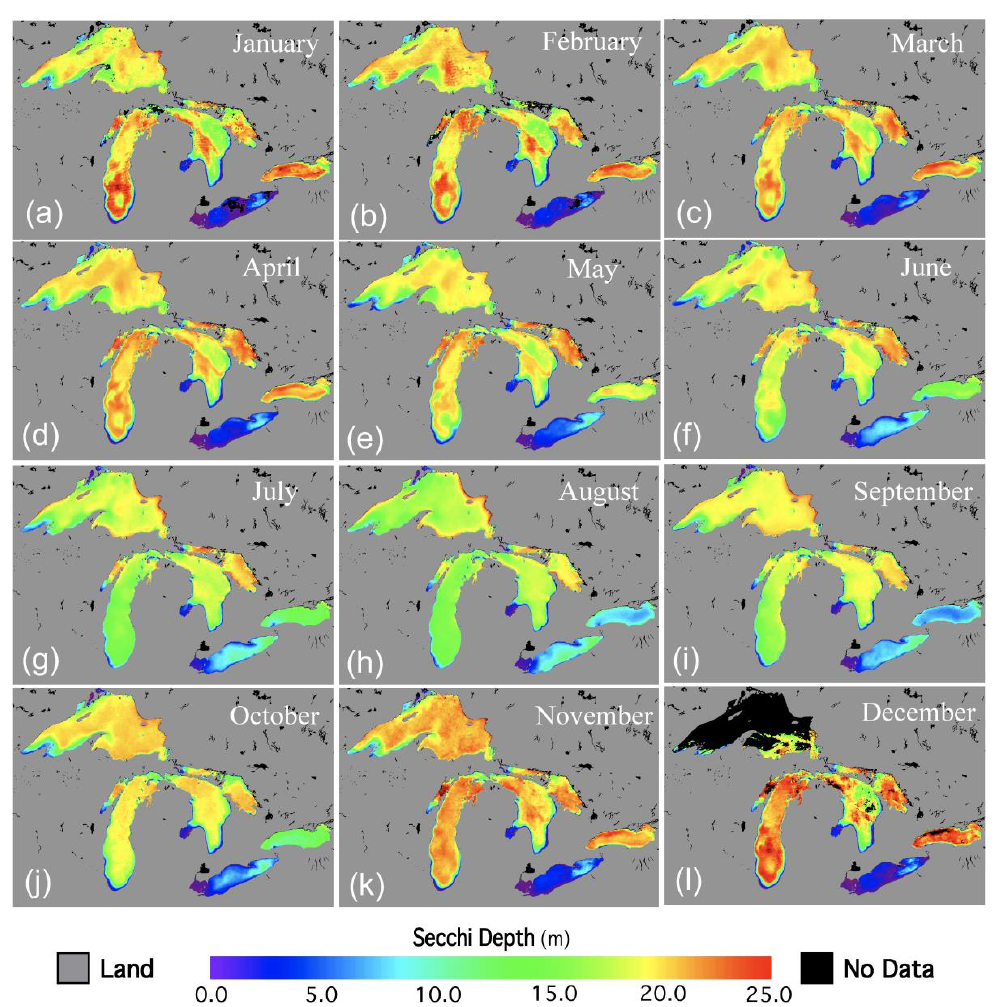
Figure 7. VIIRS-SNPP-derived monthly climatology (2012–2019) SD images of the Great Lakes for January to December (a–l).